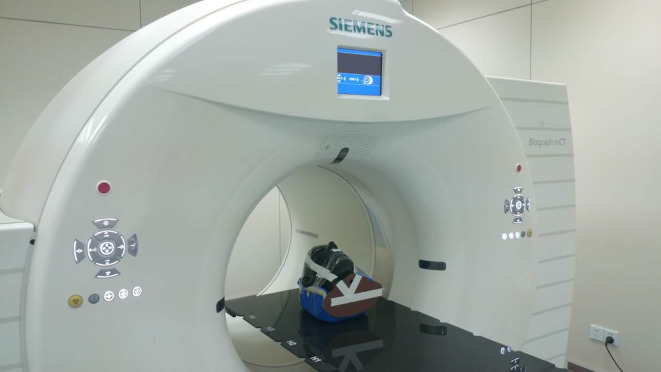
Diagram of carbon-ion virtual target irradiation experimental plan.